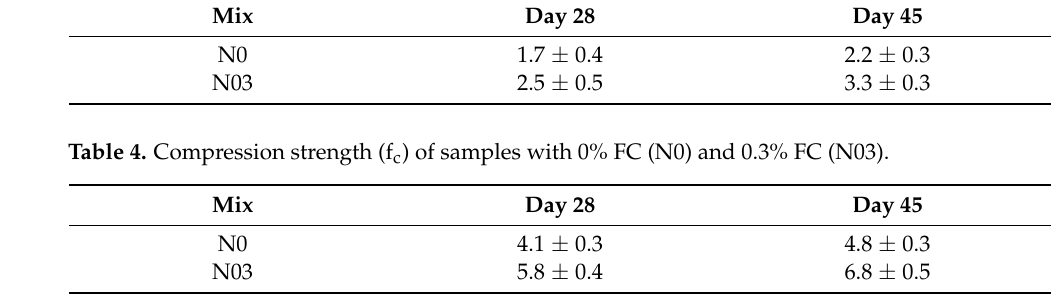
Figure 12. Representative flexural stress–strain curves from the three-point-bending test for samples with 0% (N0) and 0.3% (N03) FC.